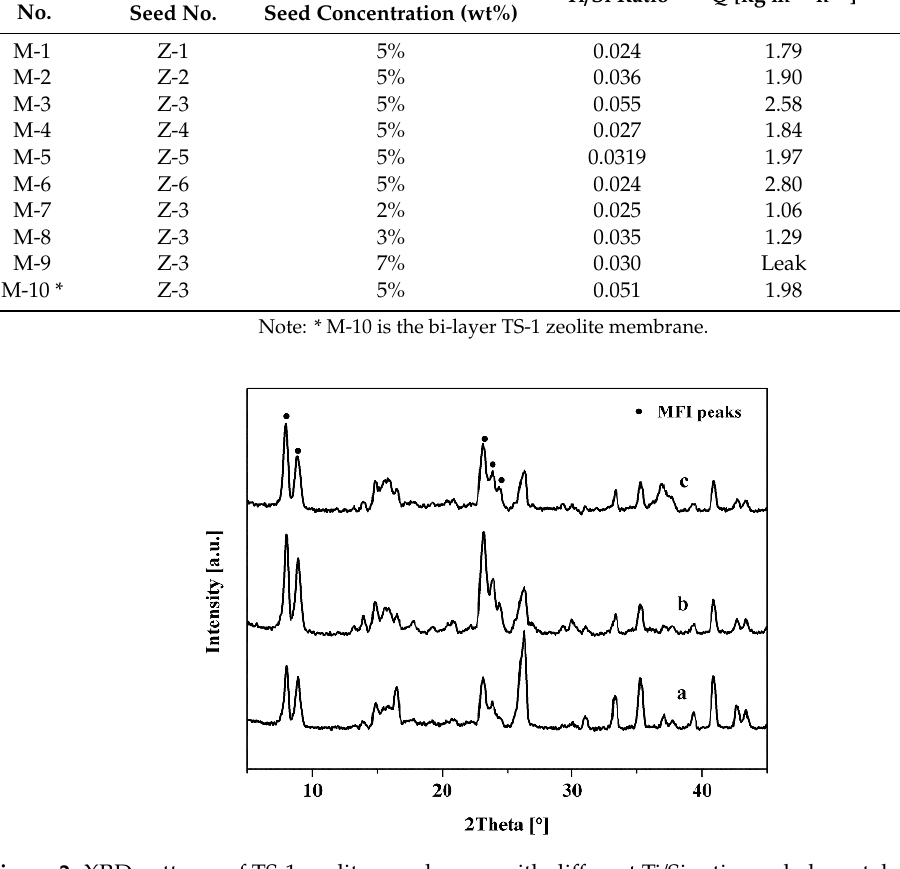
Figure 3. Surface and cross-section SEM images for TS-1 zeolite membranes with different Ti/Si ratio seed crystals, ( a , b ) M-1; ( c , d ) M-2; ( e , f ) M-3. As given in Figure 2, all diffraction peaks of the membranes M-1, M-2, M-3 were the MFI zeolite structure (2 θ = 7.8°, 8.8°, 23.2°, 23.8°) and mullite support diffraction peaks, which indicated that all membranes had pure MFI phase [21–24]. Besides, Figure 3 presented that the mullite surface was fully covered with the TS-1 zeolites. Table 2 summarized the Ti/Si ratio of the membranes by EDX characterization, which was increased with the Ti/Si ratio of the seeded crystals. The Ti/Si ratio of the membrane M-1 was low (0.024, Table 2), the catalytic performance of the membrane M-1 was poor, the total flux and IPA conversion of membrane M-1 were only 1.79 kg·m − 2 ·h − 1 and 37.78%. The accompanying TS-1 zeolites of the TS-1 zeolite membranes were collected in this work, the number of the accompanying zeolites of the membranes M-2 and M-3 were S-2 and S-3. Figure 4 showed the FT-IR spectra of the TS-1 zeolites. The peak at ca. 960 cm − 1 of the spectra was ascribed to the interaction between the stretching vibration of [SiO 4 ] unit and titanium in neighboring coordination sites, which was an evidence of the vibration of Si–O–Ti bond in the zeolite framework. As given in Figure 4, the zeolite S-3 had a higher tetrahedral titanium adsorption peak (ca .960 cm − 1 ) than the zeolite S-2. Besides, the M-3 had a higher Ti/Si ratio than the M-2 by EDX characterization (Table 2), the total flux of the membrane M-3 and IPA conversion of oxidation were up to 2.58 kg·m − 2 ·h − 1 and 98.18%, respectively. Hence, the high Ti/Si